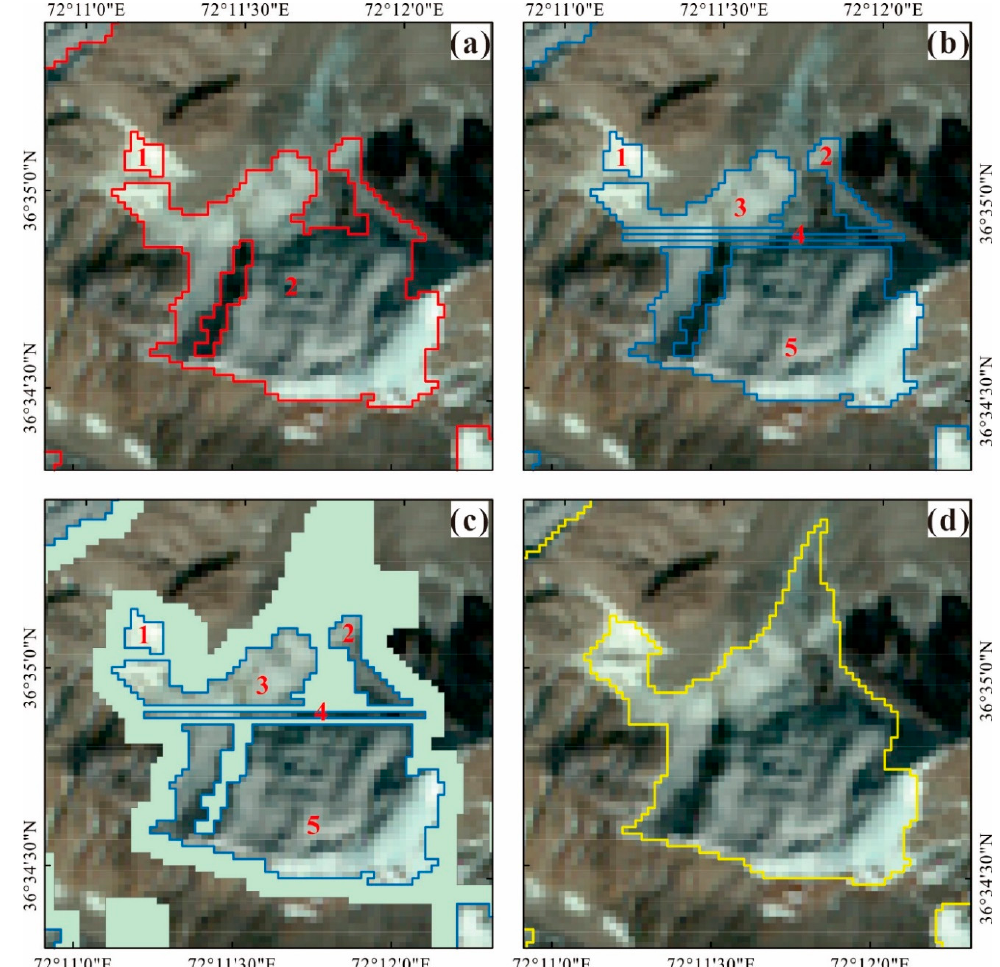
Figure 5. Local extraction based on pixels, taking image ID: LT51510352009269KHC00 as an example. ( a ) Marking ice/snow objects, ( b ) remarking ice/snow objects after segmentation, ( c ) unknown regions for ice/snow objects, and ( d ) extraction results with the watershed algorithm.